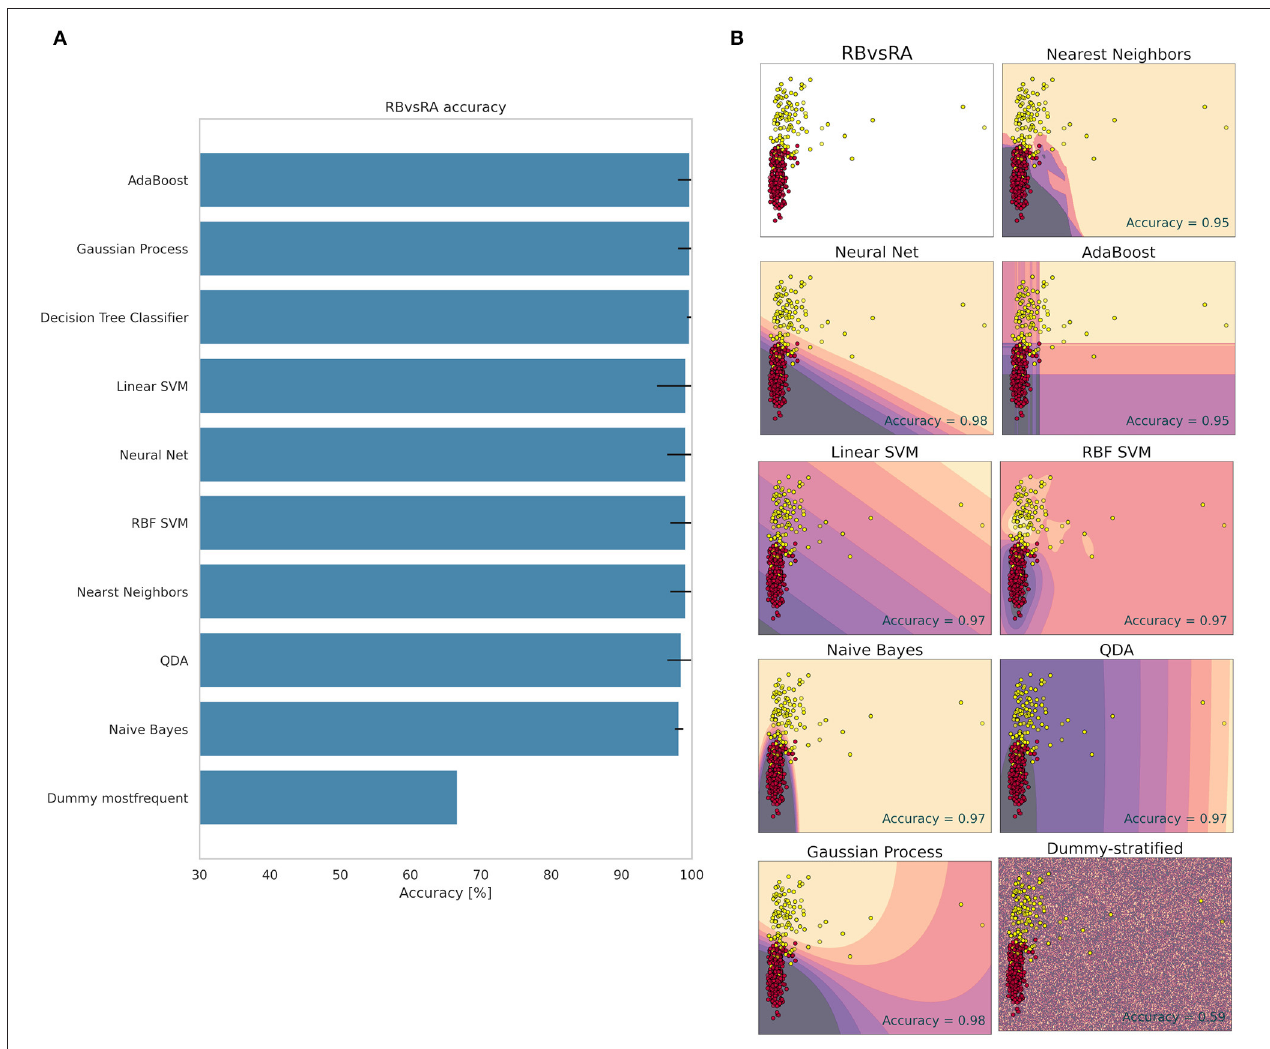
FIGURE 4 | Accuracy (%) and standard deviation (A) of the Machine Learning models used to classify RB and RA groups. Scatter plots (B) showing a sample space plan used in ML training for the RB × RA distribution. Red dots: RB; Light yellow spots: RA. The regions are the demarcations made by ML to indicate levels of certainty of classification. The darker it is, the more certain it belongs to the RB group. The clearer the more certainty of belonging to the RA group. The subtitle of each graph indicates the method used and in the lower right quadrant is the accuracy